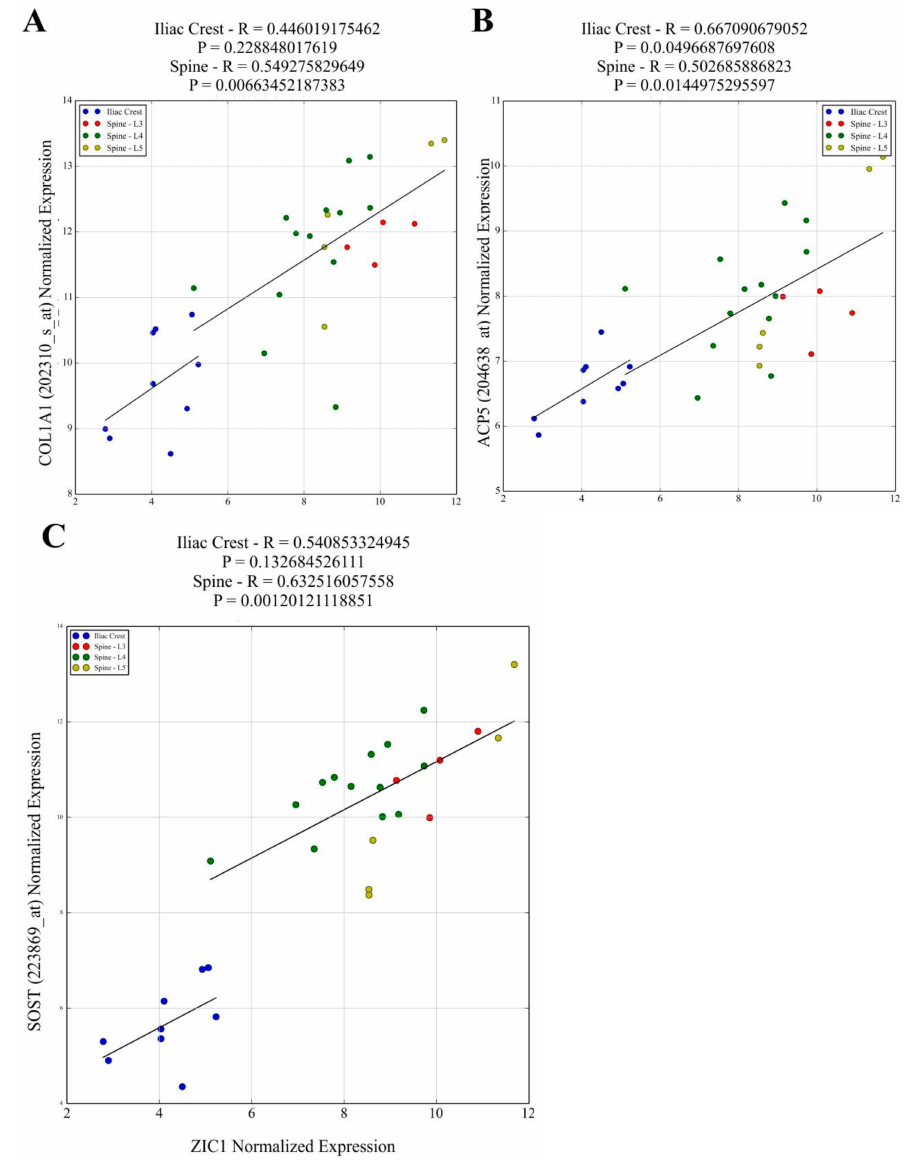
Figure 2. Affymetrix ZIC1 signal values were correlated with signal values for the transcripts reflecting osteoblast matrix-forming activity. Transcripts for ( A ) COL1A1 , IBSP* , SPARC* , BGLAP* , CDH11* and osteoblast differentiation ( BMP2* and RUNX2*) showed strong positive correlation with ZIC1 in the lumbar spine but had weaker or no correlation in IB. The PTHR1* transcript used to indicate osteoblast number also showed a strong positive correlation with ZIC1 expression. ( B ) ACP5 and CTSK** transcripts that reflect osteoclast activity showed strong positive correlation with ZIC1 expression. Osteoclast-associated transcripts CALCR** and OSCAR** showed inverse correlation with ZIC1 expression in the lumbar spine but weaker and no correlation, respectively, in the iliacus, probably due to fewer samples. The expression of osteocyte-associated transcripts ( C ) SOST , PDPN*** and MEPE*** at both high (LS) and low (IB) bone turnover sites showed strong correlation with ZIC1 mRNA. (Please see Supplementary Figure S1. A*, B** and C*** for